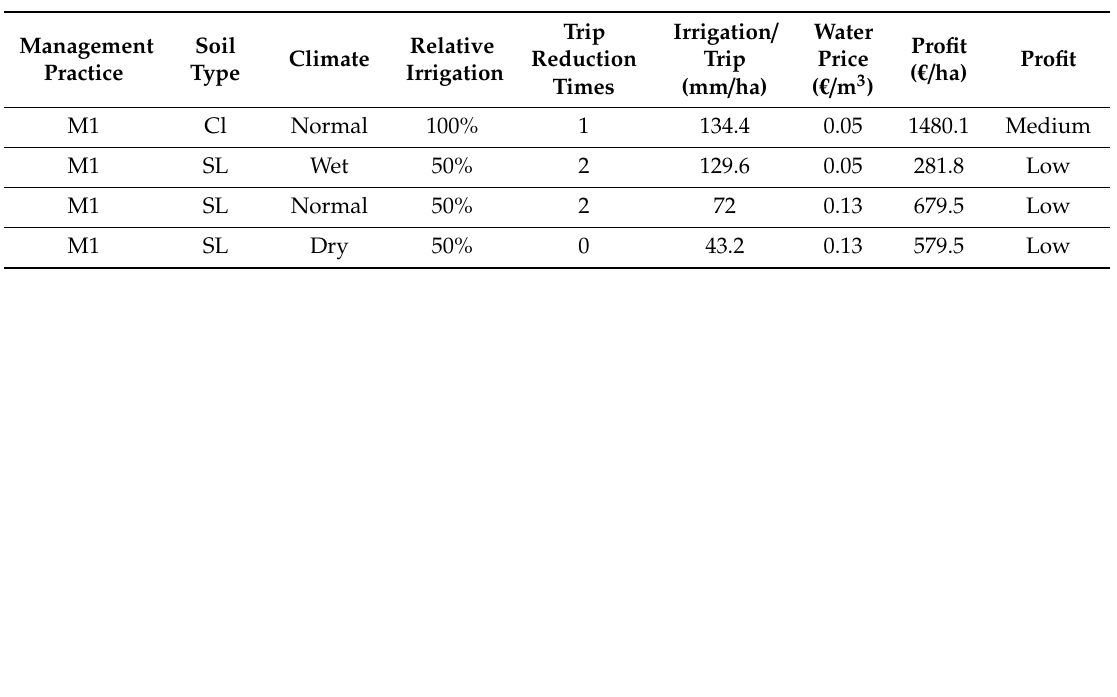
Table 15. Decision tree sample training